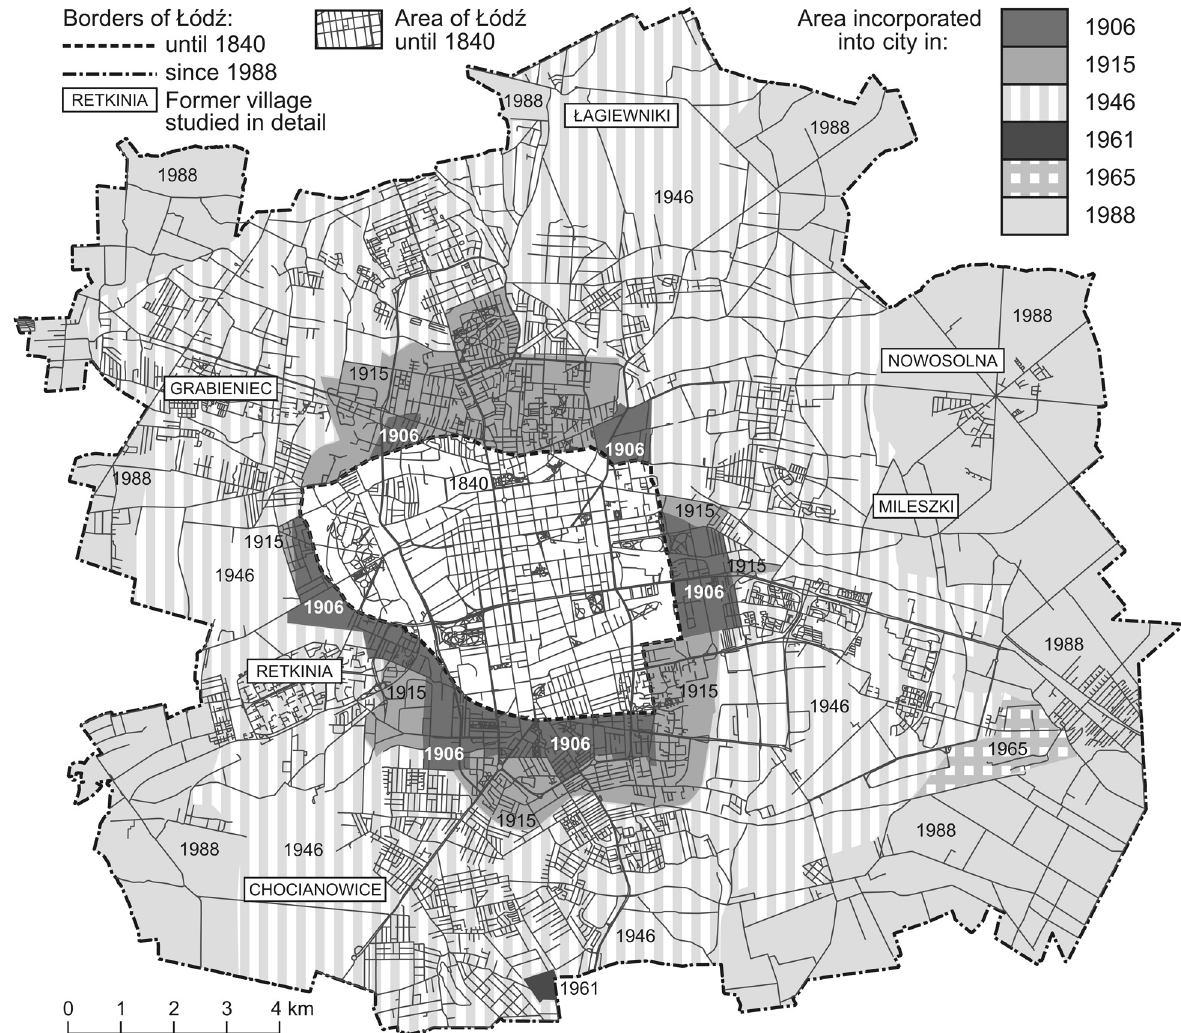
Fig. 1. Process of incorporation of rural areas into the city of Łodź in 20th century. Source: own compilation based on Szambelan, Stępniewski